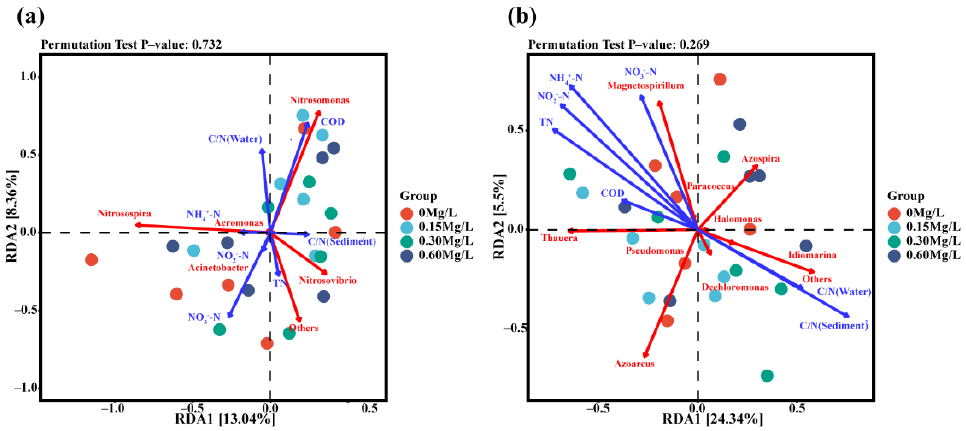
Figure 9. Redundancy analysis of nitrifying bacteria ( a ), denitrifying bacteria ( b ), and environmental factors at genus level.